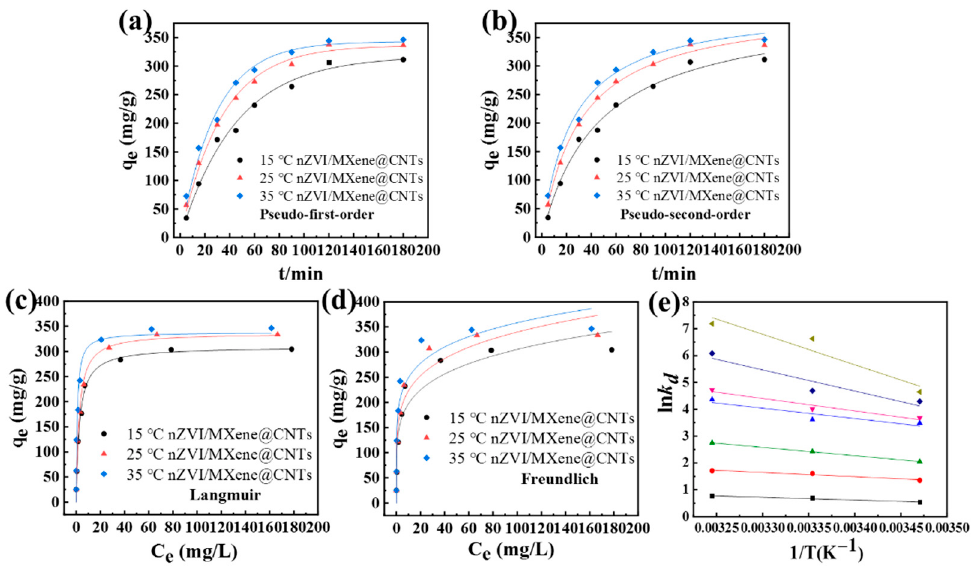
Figure 5. ( a ) Pseudo-first-order and ( b ) pseudo-second-order models of nZVI/MXene@CNTs; ( c ) Langmuir and ( d ) Freundlich isotherms models of nZVI/MXene@CNTs; ( e ) thermodynamics of nZVI/MXene@CNTs at different temperatures.